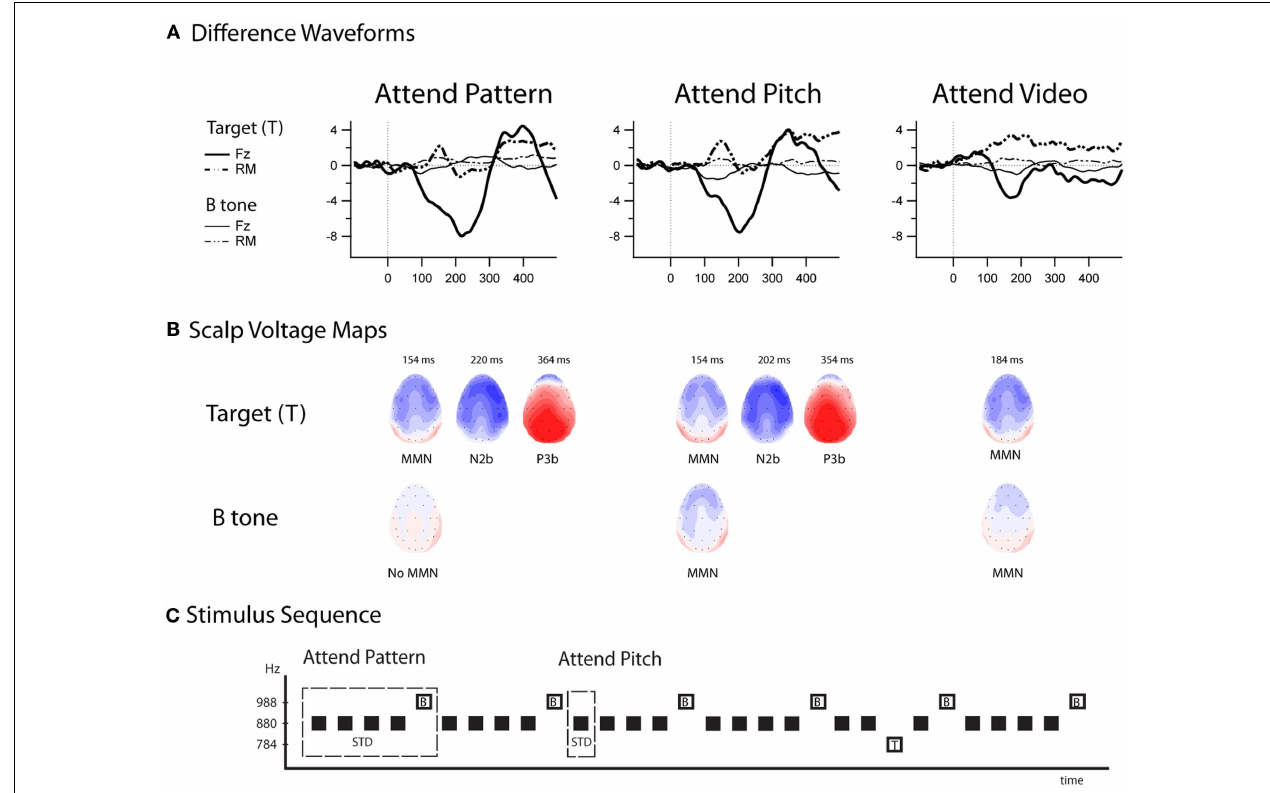
the head shots, and the ERP components labeled below). No MMN was elicited by the B tone in the Attend-Pattern condition.Target-N2 and P3b components were not elicited in the Attend-Video condition, in which the sounds were ignored. (C) Stimulus sequence (bottom row) is displayed as a reminder of the stimulus-eliciting tones. “T” denotes the target tones when sounds were attended and “B” denotes the fifth tone of the